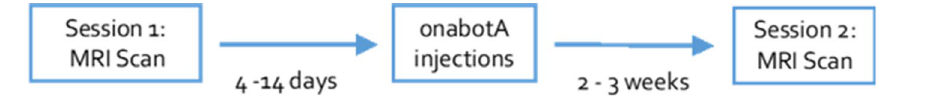
Figure 1. Schematic of study design.